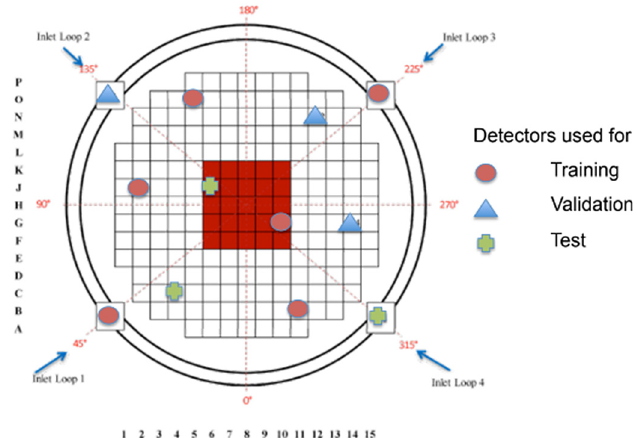
Fig. 2. Modelled core layout with 8 in-core and 4 ex-core detector locations shown for one axial plane. Corresponding train, test and validation detector splits shown, with central 5 (cid:3) 5 FA cluster shown in